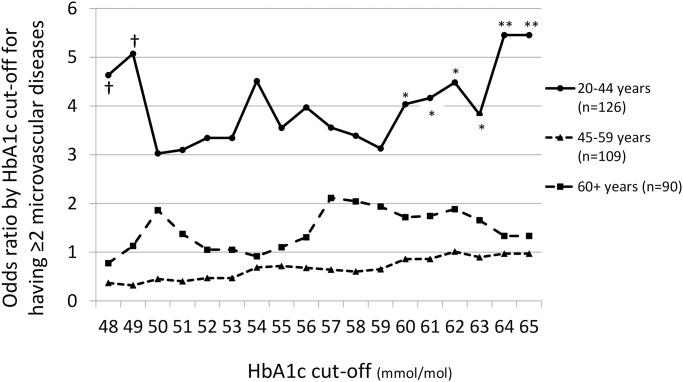
Odds ratios for ≥2 microvascular diseases in those in each of three age categories with an HbA1c greater than or equal to HbA1c cut-offs between 48 and 65 mmol/mol.Significant odds ratios are denoted by: * p<0.05; ** p<0.01. † 95% confidence intervals for the 48 and 49 mmol/mol HbA1c cut-offs were 0.4–49.5 and 0.5–51.8 mmol/mol, respectively, indicating unreliable odds ratio estimates due to small numbers (<40) in the lower HbA1c range. At higher HbA1c cut-offs, the upper bound of the 95%CI did not exceed 26 mmol/mol.